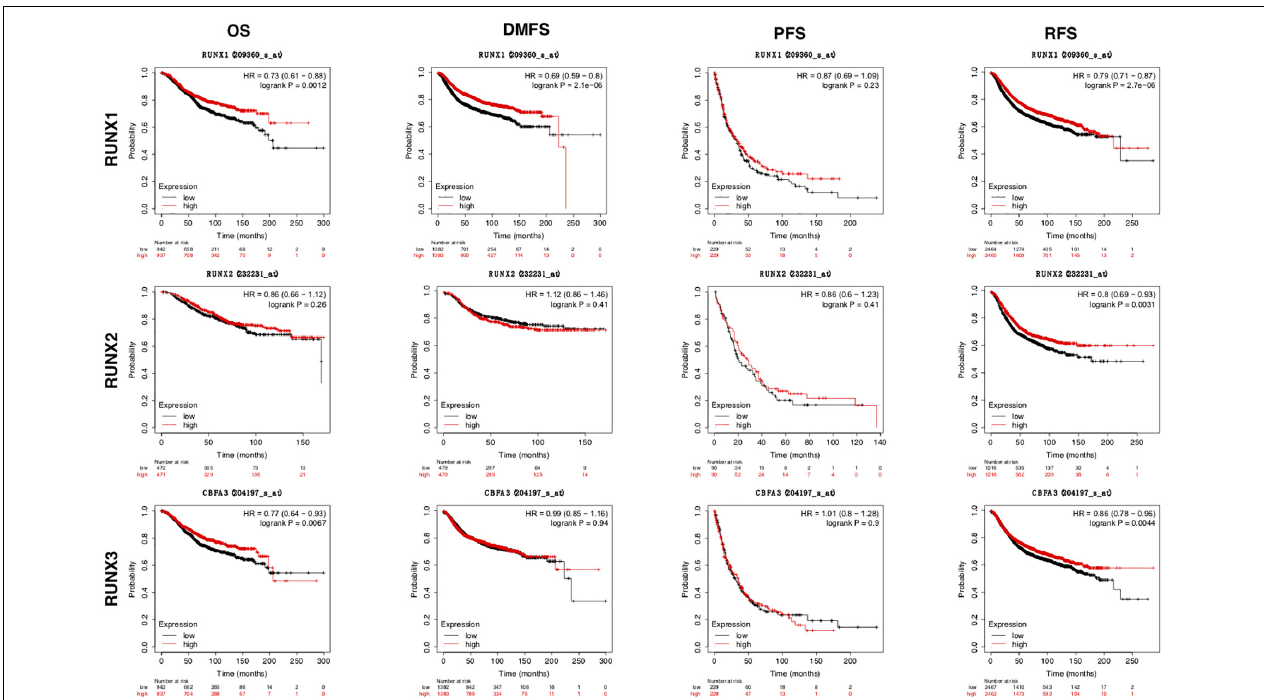
FIGURE 4 | The prognostic value of RUNX transcriptional level in breast cancer patients. The breast cancer patients were classified into two groups by the median expression levels of RUNX1, RUNX2, or RUNX3. The overall survival (OS), distant metastasis-free survival (DMFS), progression-free survival (PFS), and relapse-free survival (RFS) were compared between patients with high or low expression of RUNX transcription factors.